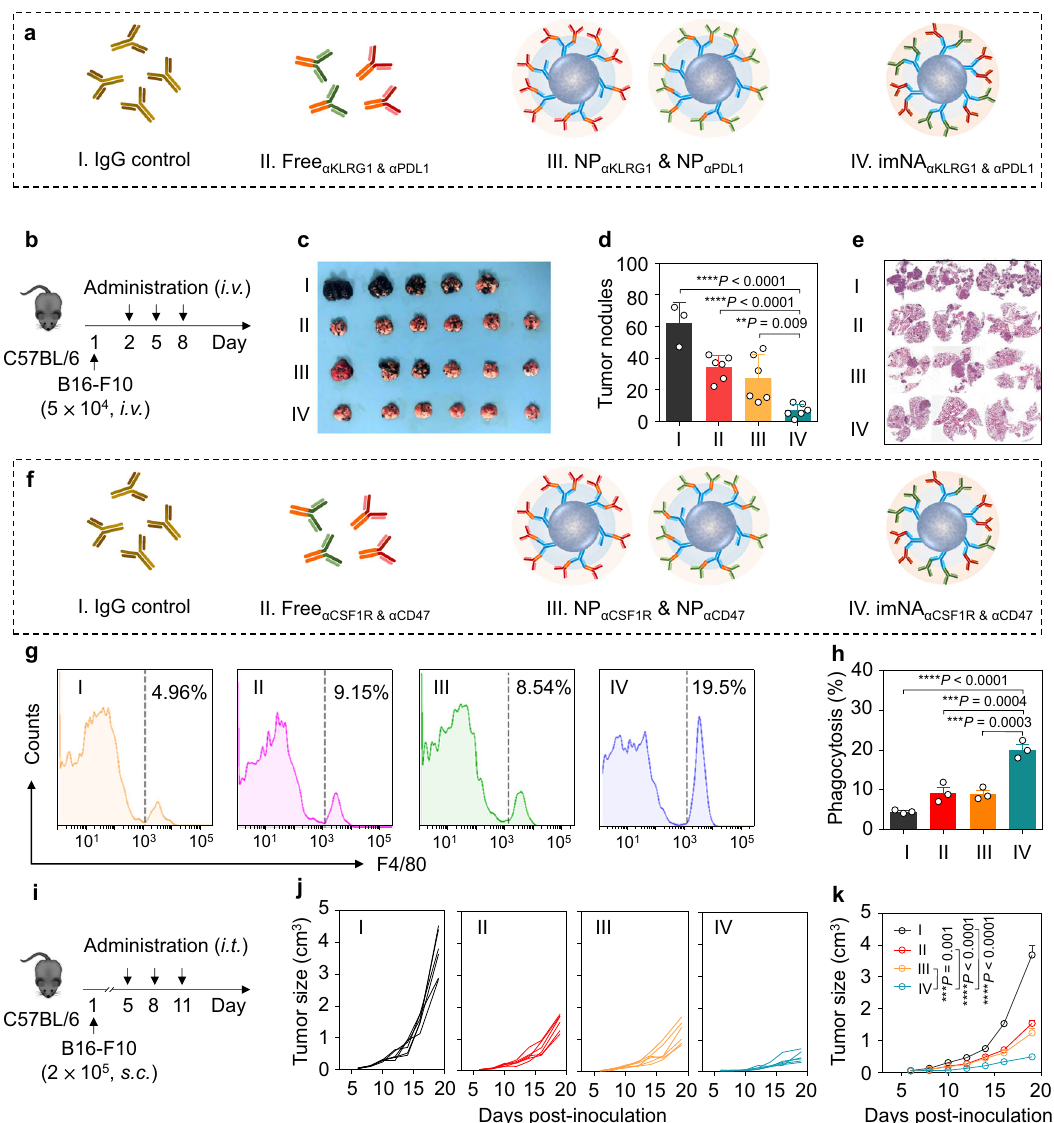
Fig. 5 α Fc-NP serves as a versatile antibody immobilization platform and imNAs enhance the anti-tumor effect of multiple immunomodulatory mAbs. a imNA was constructed to enhance the antitumor activity of NK cells, and the following four groups were established: (1) IgG control; (2) Free α KLRG1 & α PDL1